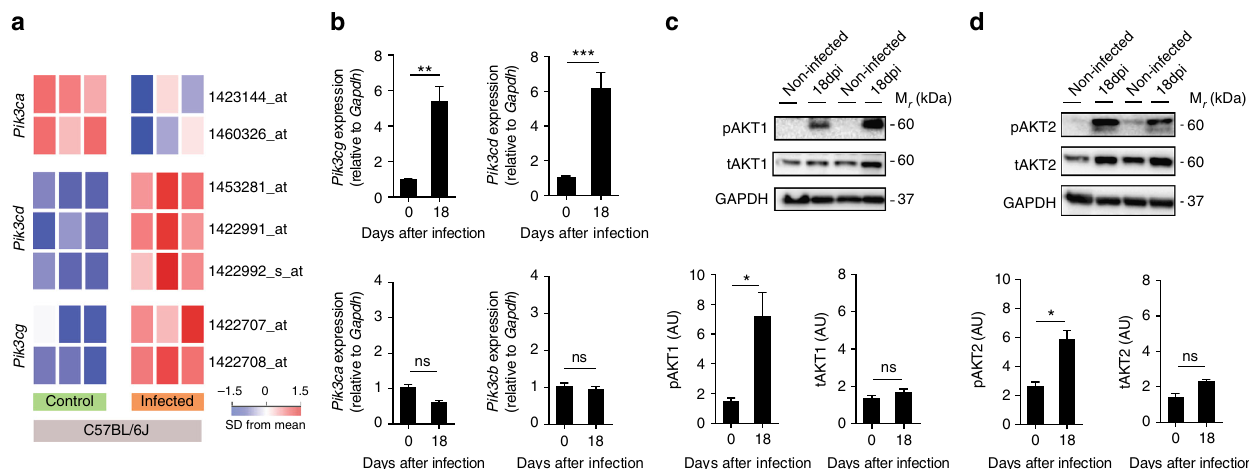
Fig. 1 The PI3K γ signaling is enhanced in the heart tissue of mice after experimental infection with T . cruzi . a Transcriptome analysis for the expression of Pik3ca , Pik3cd , and Pik3cg genes in non-infected C57BL/6J mice or 18 days post infection with T . cruzi . b RT-PCR analysis of the mRNA expression of Pik3ca , Pik3cb , Pik3cd , and Pik3cg genes in the heart tissue of C57BL/6 non-infected mice ( n = 7) or 18 days post infection with T . cruzi Y strain ( n = 11). Gapdh was used as a housekeeping gene. c Representative western blots and analysis of phosphorylated (p) and total (t) AKT1 expression in the heart tissue of non- infected C57BL/6 mice or 18 days post infection with T . cruzi ( n = 6). GAPDH was used as a loading control. d Representative western blots and analysis of phosphorylated (p) and total (t) AKT2 expression in the heart tissue of non-infected C57BL/6 mice or 18 days post infection with T . cruzi ( n = 6). GAPDH was used as a loading control. AU refers to arbitrary units ( c , d ). * P < 0.05, ** P < 0.01, *** P < 0.001, and ns = no statistical signi fi cance (unpaired Student ’ s t- test in b – d ). Data are representative of two ( b – d ) independent experiments (mean ± s.e.m in b – d